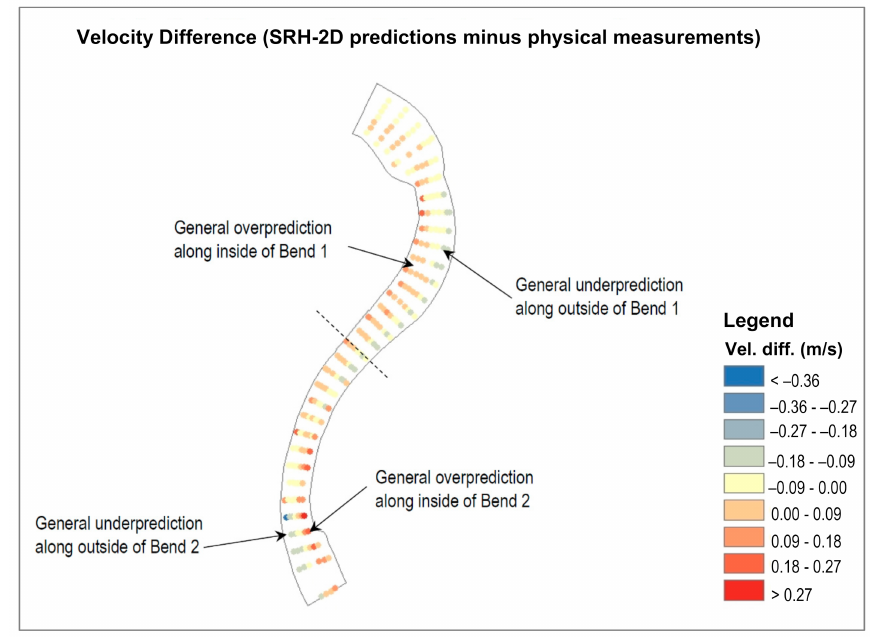
Figure 17. Baseline point and contour difference in values of predicted and measured velocities. The velocity differences are compared in Figure